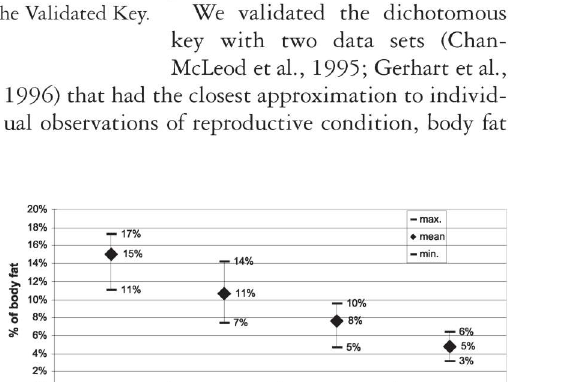
Fig. 1. Development of the Dichotomous Key to predict body condition in Caribou. Conceptual key as based on the presence and absence of fat in caribou (proposed by R. G. White, 2000, see Kofinas et al., 2001). The conceptual key was validated against datasets of body composition (Fig. 2) and modified to make linear the response noted in the Validated Key.